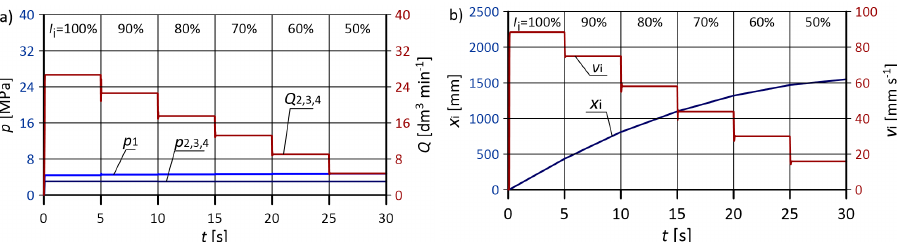
Figure 6. Results of the base system, equal load force F load , i = 15 kN; ( a ) pressures and flow rates, ( b ) speeds and positions of actuators.